Question: Briefly state, in one sentence, what is plotted here.
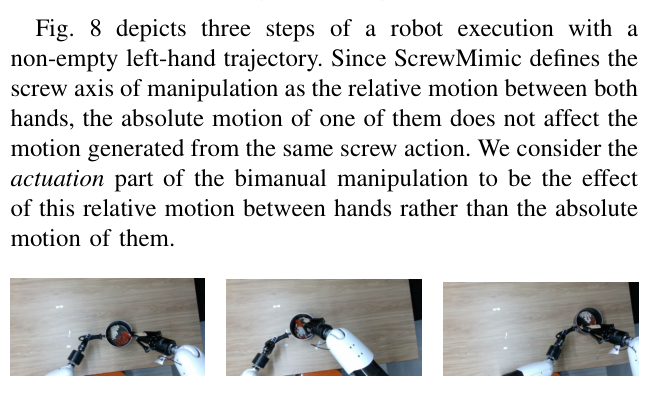
Answer: depicts three steps of a robot execution with a non-empty left-hand trajectory. Since ScrewMimic defines the screw axis of manipulation as the relative motion between both hands, the absolute motion of one of them does not affect the motion generated from the same screw action. We consider the actuation part of the bimanual manipulation to be the effect of this relative motion between hands rather than the absolute motion of them.